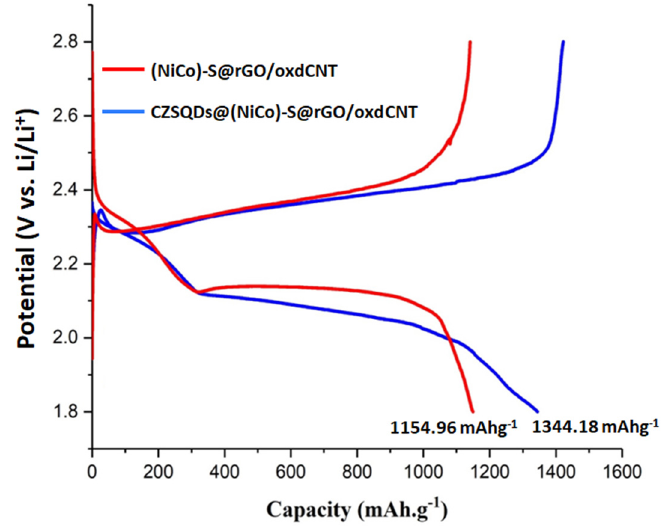
Figure 12. First initial charge/discharge curves with and without CuZnS QDs decorated (NiCo)– S@rGO/oxdCNT/S at the current density of 0.1 C.